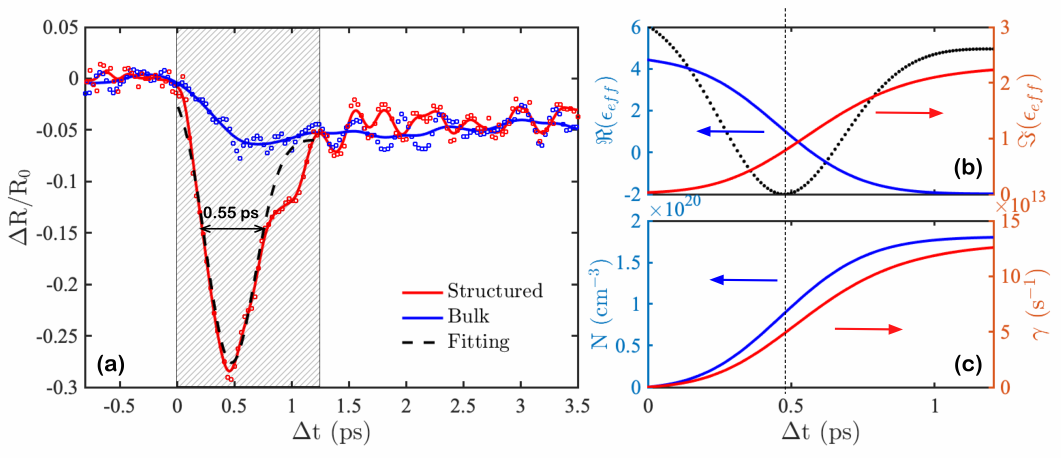
Figure 3. ( a ) The change of the reflectance ∆ R / R 0 as a function of the arrival time difference, ∆ t , between the pump and signal pulses, for a pump fluence of 10 mJ/cm 2 . The solid blue, red and dashed black lines are the experimental results for the bulk, structured silicon and the best fitting, respectively. ( b ) The evolution of the real (blue) and imaginary (red) part of the dielectric function as a function of ∆ t , reconstructed from the experimental data. The black dashed curve reproduces that shown in Panel ( a ) to assist with the interpretation. ( c ) The variation of the carrier concentration N (blue) (at the sample surface) and scattering rate γ (red) as a function of ∆ t . The vertical dotted line indicates the condition of (cid:101) → 1 when the reflectance reaches its